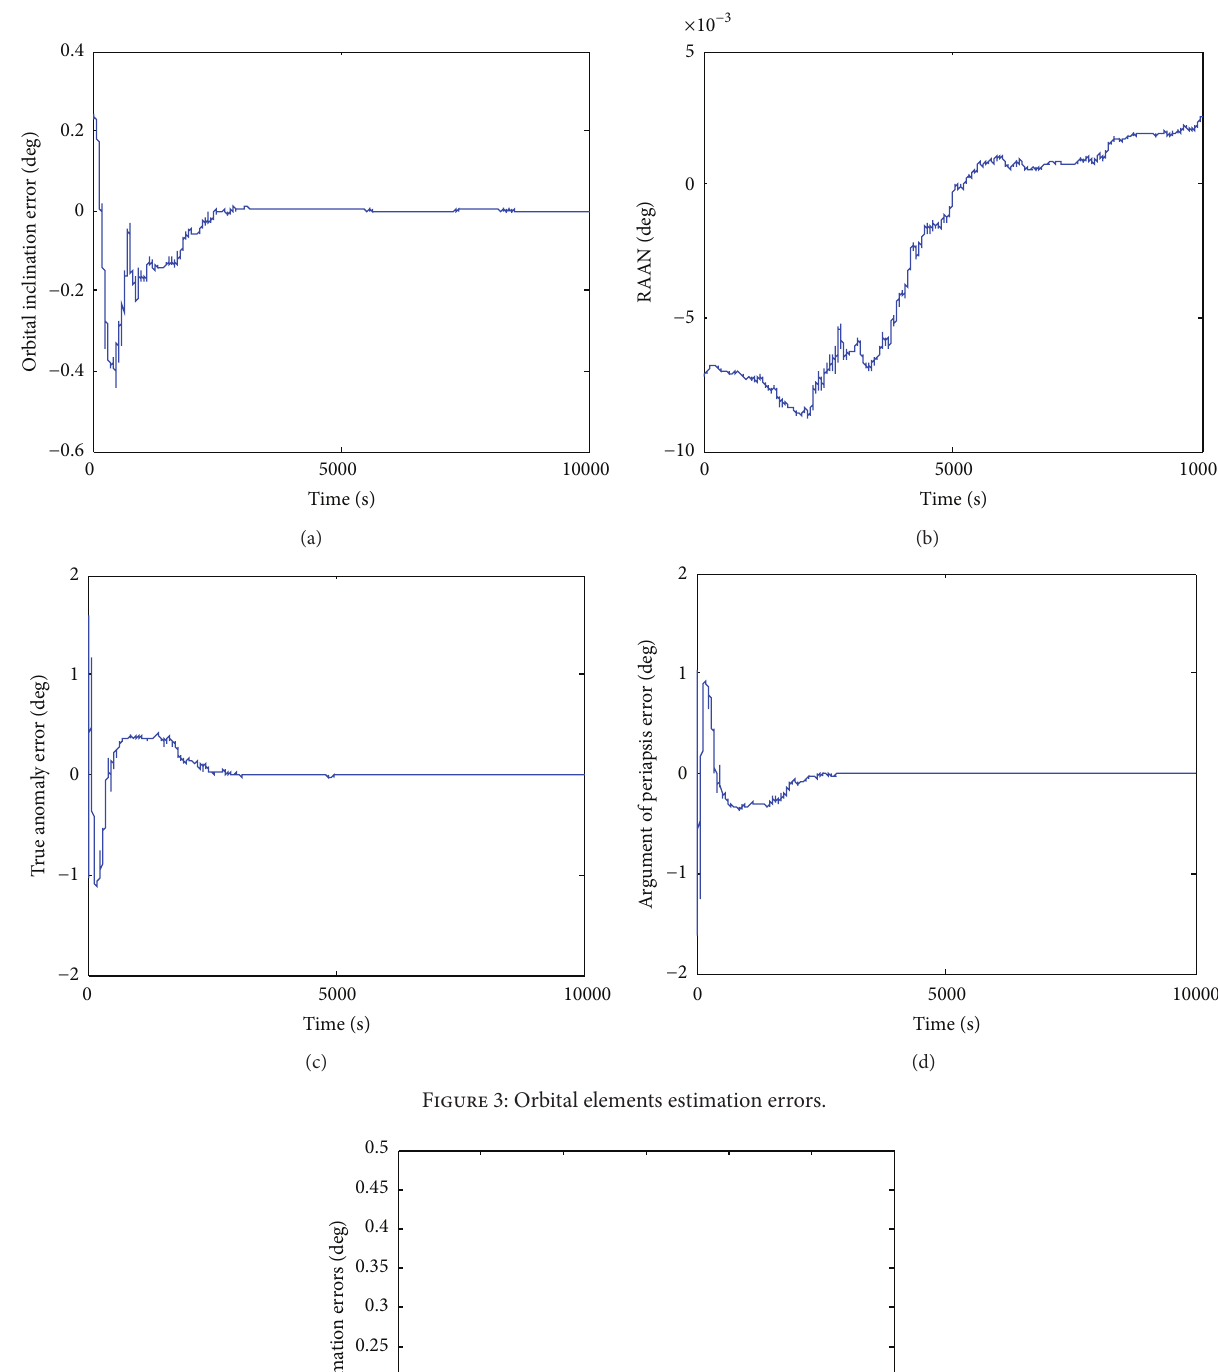
Figure 3: Orbital elements estimation errors.